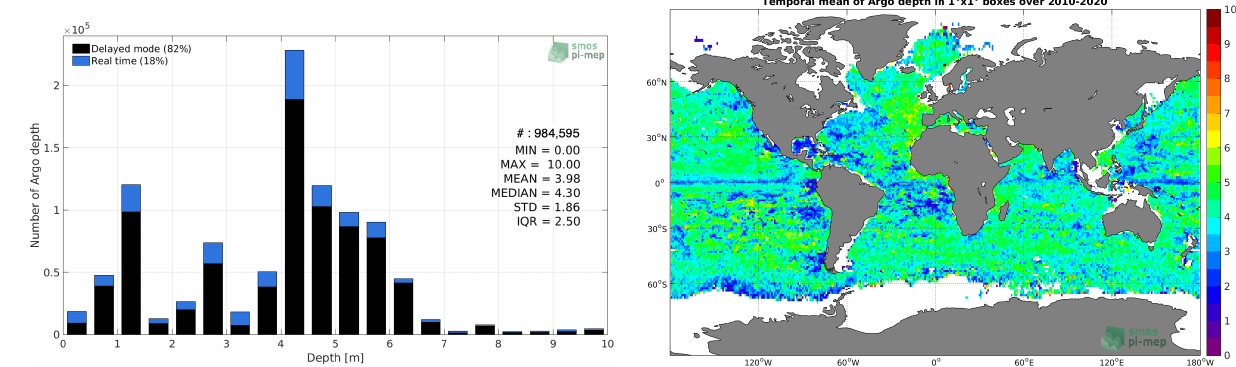
Figure 5. Histograms of the depth of the upper level SSS measurements from Argo in the Match-up Data Base for the Global Pi-MEP region ( left ) and temporal mean spatial distribution of pressure of the in situ SSS data over 1 ◦ × 1 ◦ boxes and for the full satellite product period ( right ).